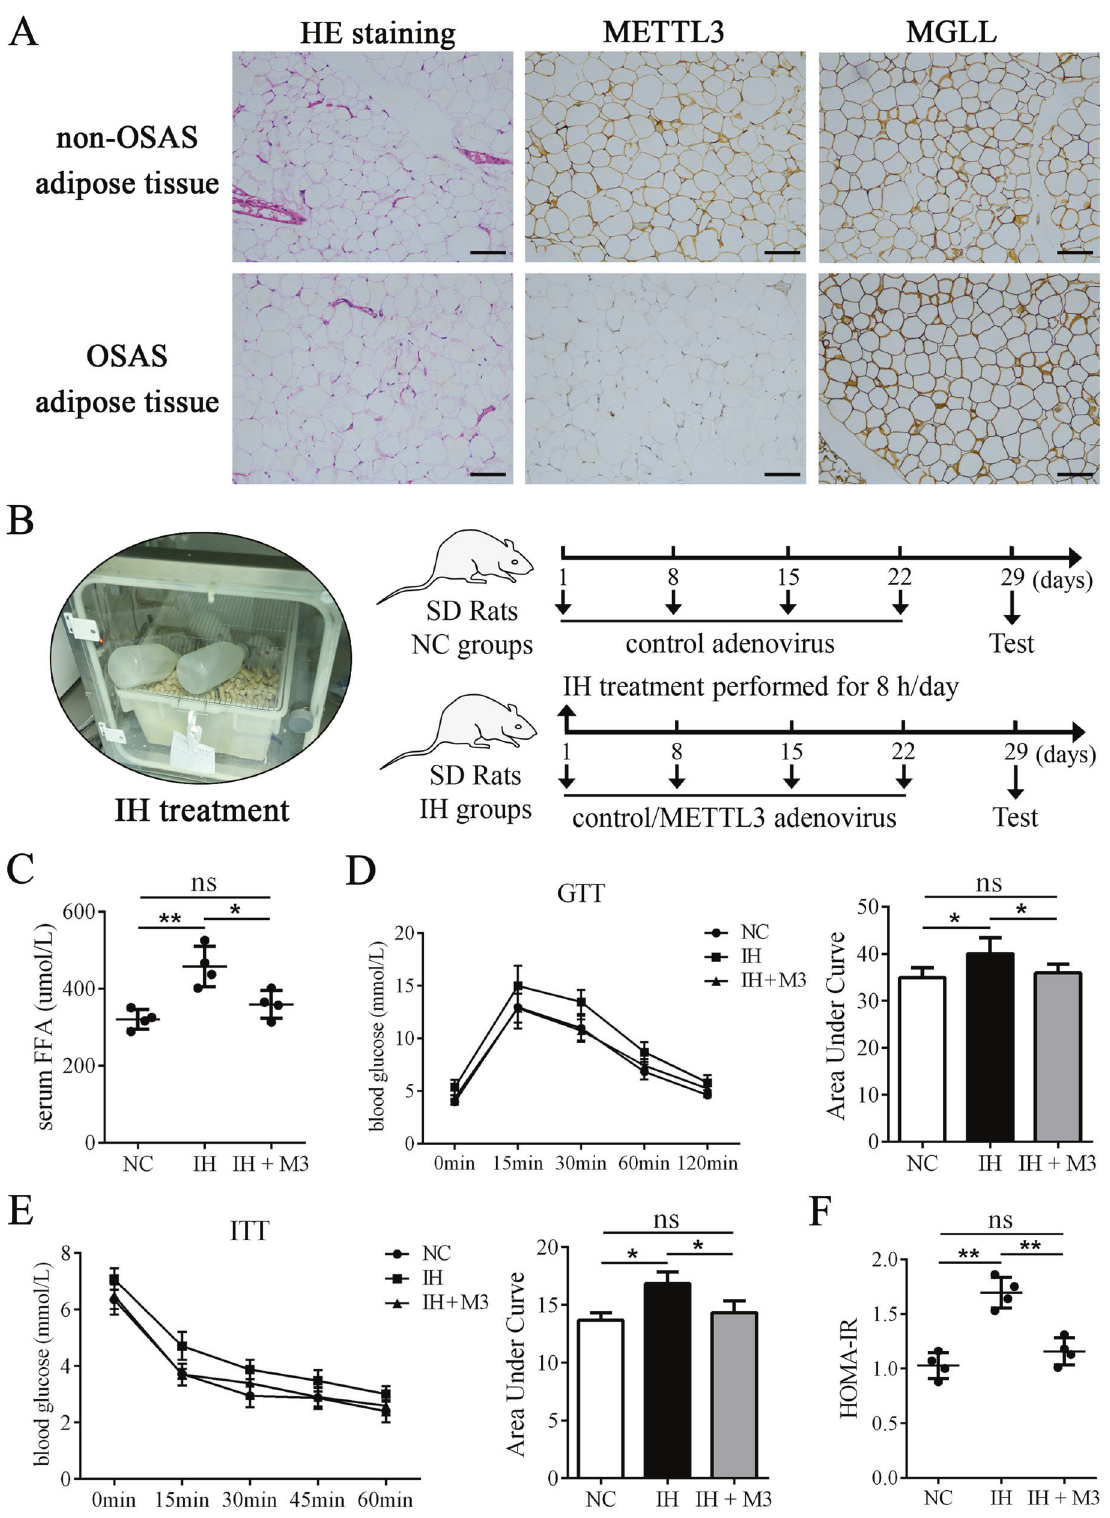
Fig. 6 METTL3 reduced FFA levels and improved IR in CIH rats. A The HE staining and immunohistochemical staining of METTL and MGLL on adipose tissues from OSAS patients and non-OSAS donors. B The schematic diagram of CIH rats construction and adenovirus injection. C The levels of serum FFAs were enhanced in CIH rats and reduced by adenovirus overexpressing METTL3. D The levels of glucose tolerance detected by GTT were decreased in CIH rats and improved by adenovirus overexpressing METTL3. E The levels of insulin sensitivity detected by ITT were decreased in CIH rats and improved by adenovirus overexpressing METTL3. F The HOMA-IR was increased in CIH rats and reduced by adenovirus overexpressing METTL3; n = 4, * P < 0.05, ** P < 0.01, ns indicates not signi fi cant. M3 means treatment of adenovirus overexpressing